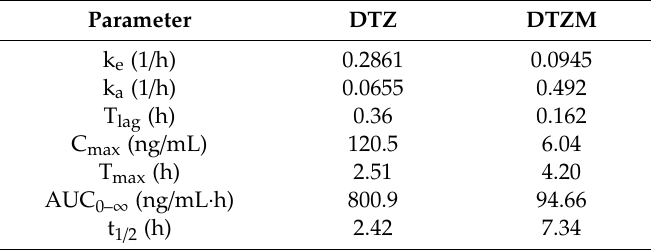
Table 4. Pharmacokinetic parameters of DTZ and DTZM estimated by one-compartmental analysis of the mean concentration – time profiles after the oral administration of 120 mg of DTZ to 19 healthy subjects.